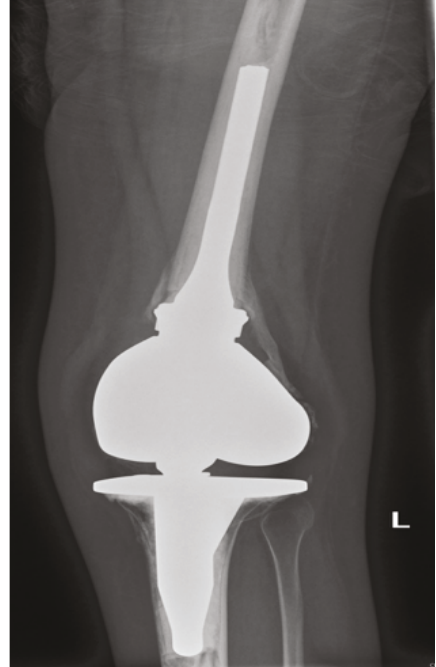
Figure 6: Postoperative plain radiograph of constrained left knee replacement.